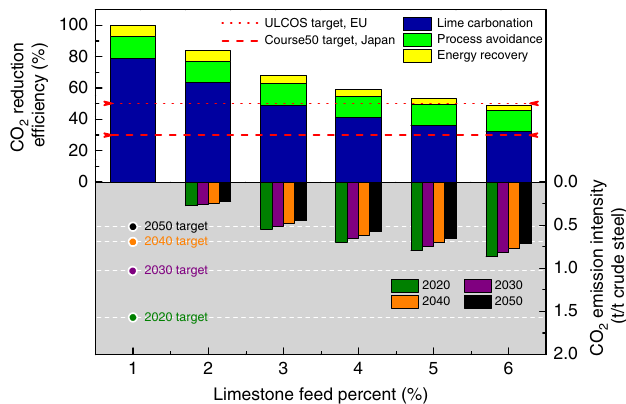
Fig. 3 Decarbonisation potential of a conventional integrated steel mill implementing the CaL-LP scheme. The CO 2 reduction ef fi ciency resulting from lime carbonation, process avoidance, and energy recovery is shown as a function of the limestone feed percent, and compared with technical targets of the COURSE50 and ULCOS programmes; The CO 2 emission intensity from 2020 to 2050 is shown as a function of the limestone feed percent, and compared with the sectoral decarbonisation targets